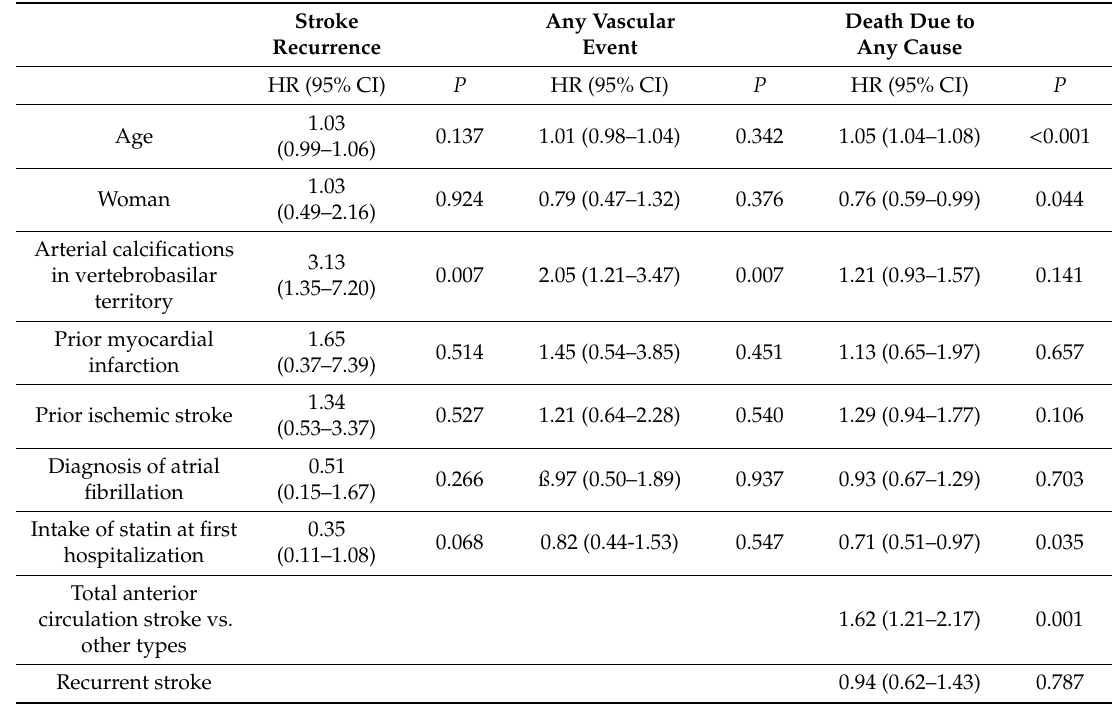
Table 4. Adjusted multivariable analysis using Cox proportional hazard model predicting stroke recurrence, any vascular event, and death in the cohort of 448 patients followed 7 years after first hospitalization due to ischemic